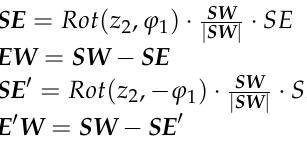
Figure 8. Geometric illustration of singular condition 3.